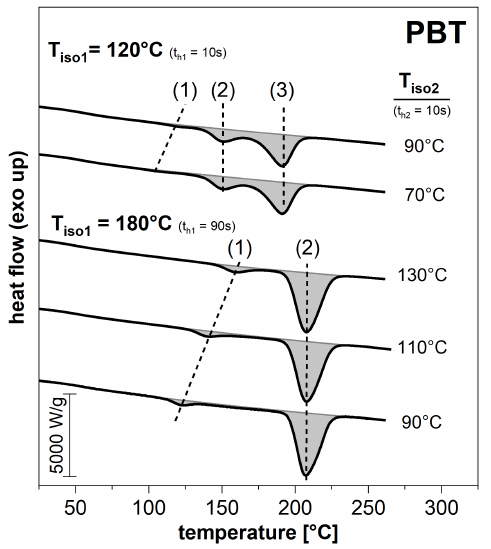
Figure 7. Exemplary first heating runs (at 1000 K/s) after the primary and subsequent secondary crystallization at T iso 1 and T iso 2 , respectively, obtained with the FSC. The holding time at T iso 1 was 10 s (120 °C), respectively, 90 s (180 °C), and 10 s at T iso 2 .